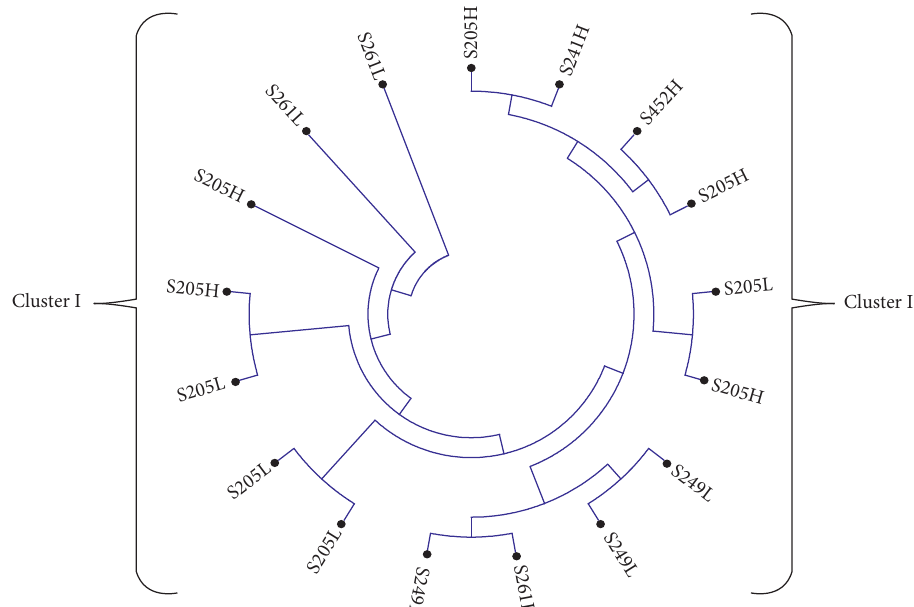
Figure 3: A neighbor-joining phylogenetic tree for Sasso LEI0258 DNA sequences generated by using the full likelihood distance and general reversible model. In branch name, S is Sasso; the number is allelic size in base pair (bp); H is high susceptible; and L is less